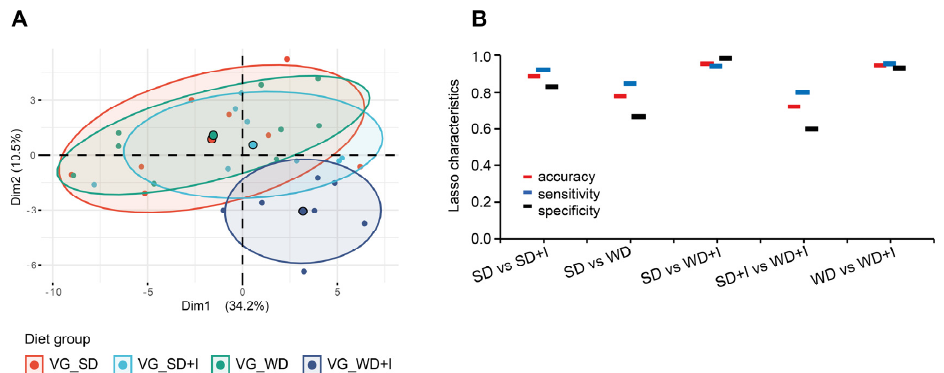
Figure 5. Cecum VOCs composition. ( A ) The 2D PCA scores plot. The explained variance of each component is included in the axis labels. The large points represent the centroids of each group. ( B ) Held-out characteristics of Lasso logistic regression model.